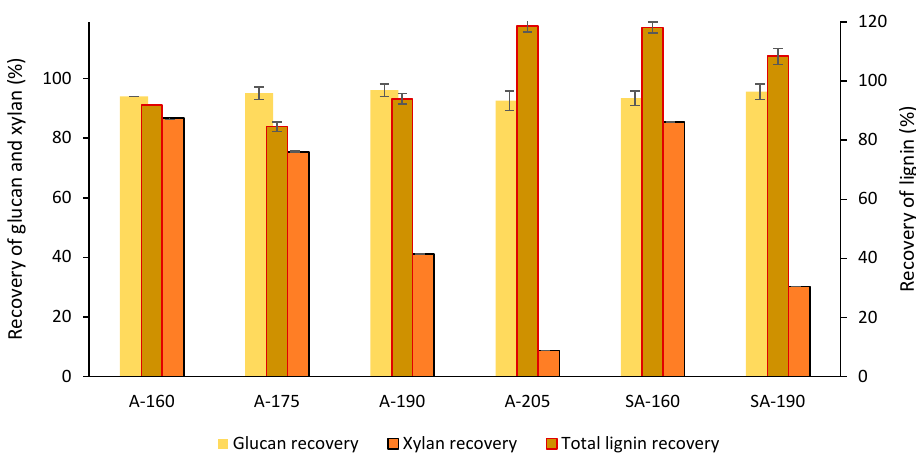
Figure 2. Recovery of glucan, xylan, and total lignin (Klason lignin plus acid-soluble lignin (ASL)) in the pretreated solids. The codification of the experimental conditions is the same as in Table 1.